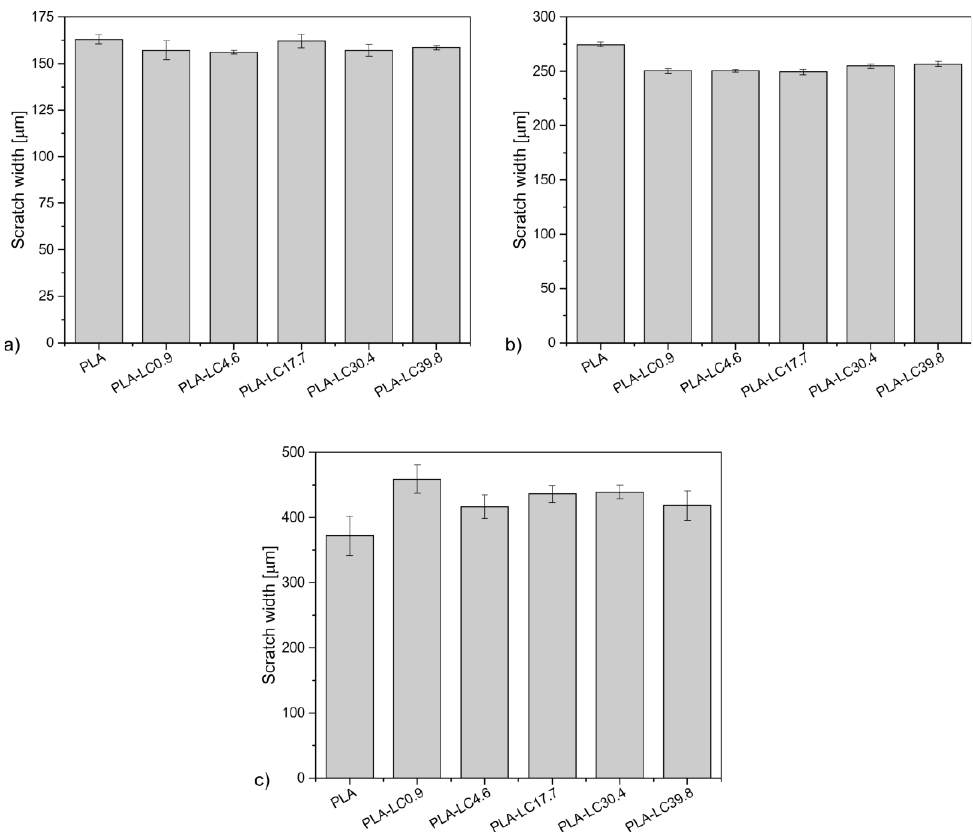
Figure 4. Scratch width created on samples under the load of 10 N ( a ), 20 N ( b ), and 40 N ( c ).